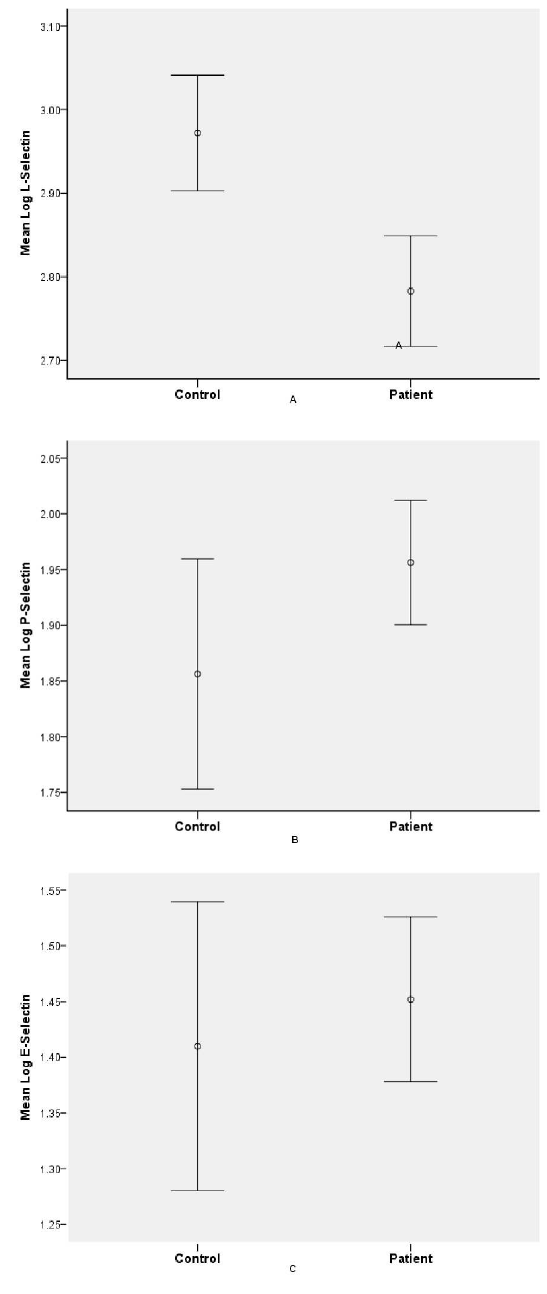
Fig 1. Plasma soluble L-selectin (A), P-selectin (B) and E-selectin (C) levels in patients with schizophrenia and healthy controls. Error bars are representing95% confidenceintervals, and the little circle stands for the mean of the log-transformed value of each selectin. Plasma solubleP-, E- and L-selectin concentration were log transformed to normalizethe data. Geometric means reportedin the text were calculatedby exponentiatingmean log-transformed P-, E- and L-selectinfor adjustedand unadjusted comparisons of patients and controls. seen in unmedicated patients fosters the spread of immune cells from the periphery to the brain (leading to activation of the resident microglial cells) and antipsychotic medications may